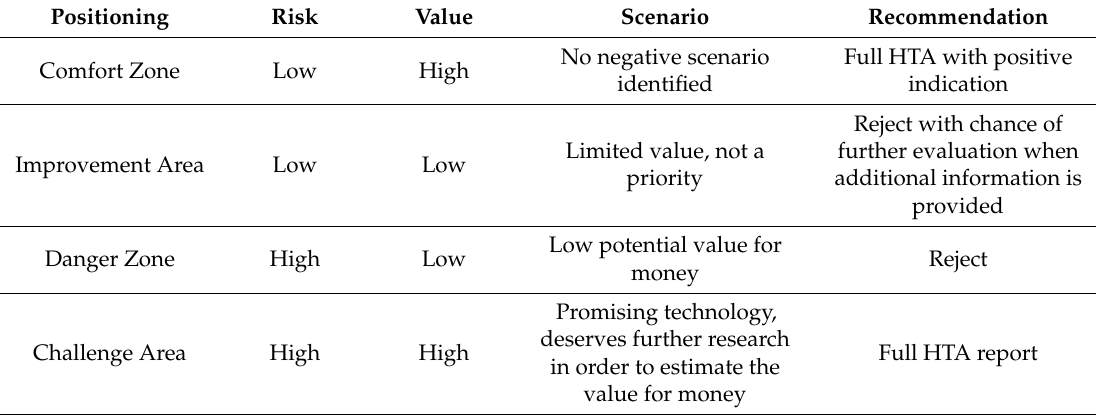
Table 2. Technology positioning